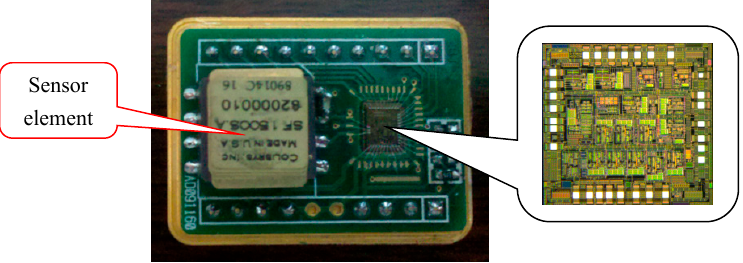
Figure 9. The printed circuit board photograph of ΣΔ modulator interface chip circuit